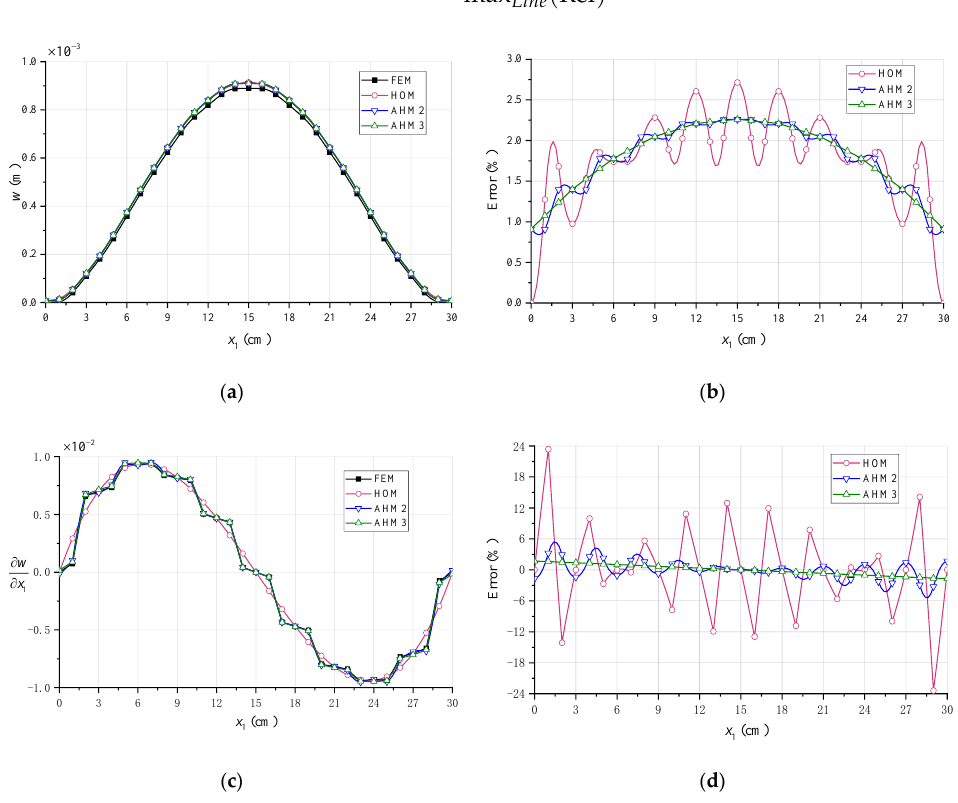
Figure 13. Deformations of the CFCF periodic layered plate along Line A. ( a ) w ; ( b ) Error of w ; ( c ) ∂ w / ∂ x 1 ; ( d ) Error of ∂ w / ∂ x 1